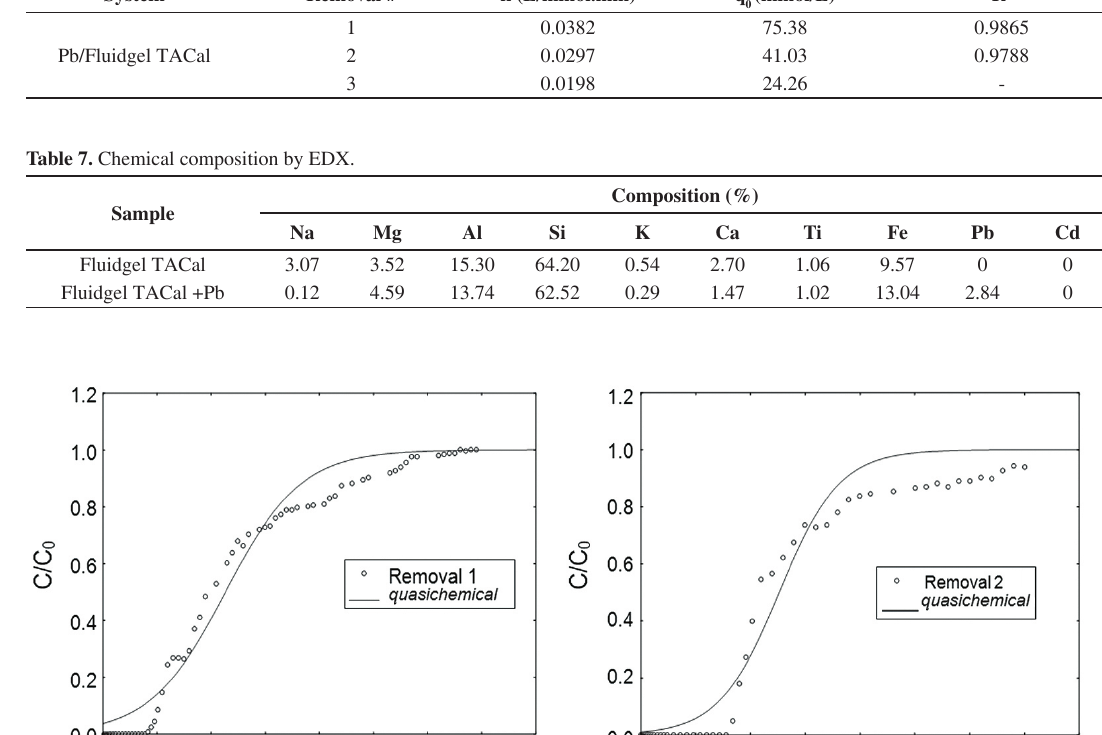
Table 6. Fitting parameters of Adams-Bohart model for breakthrough curves in beds regenerated by CaCl System